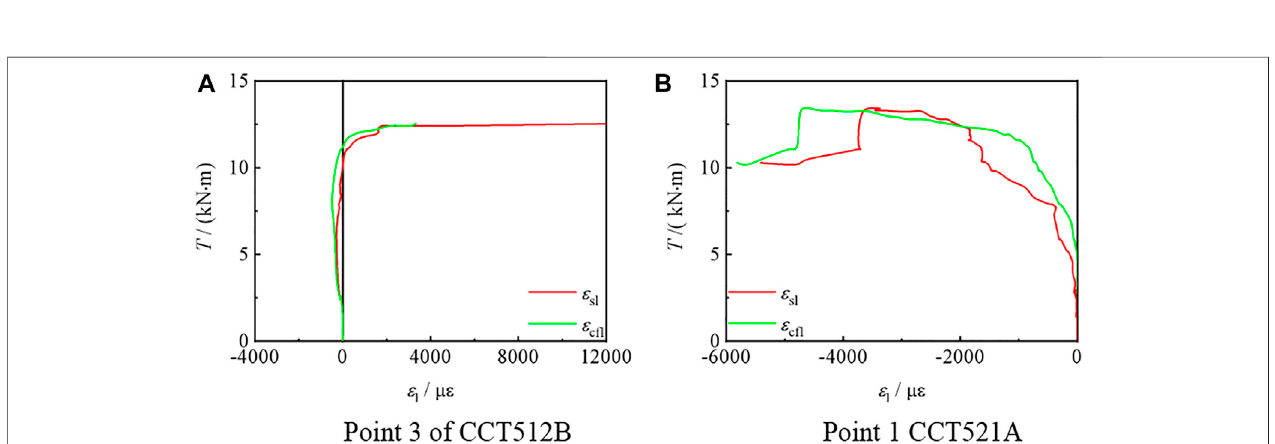
FIGURE 8 | T – ε t curve of the partial C-CF-CFRP-ST specimen. (A) Transverse strain of steel tube and (B) CFRP.